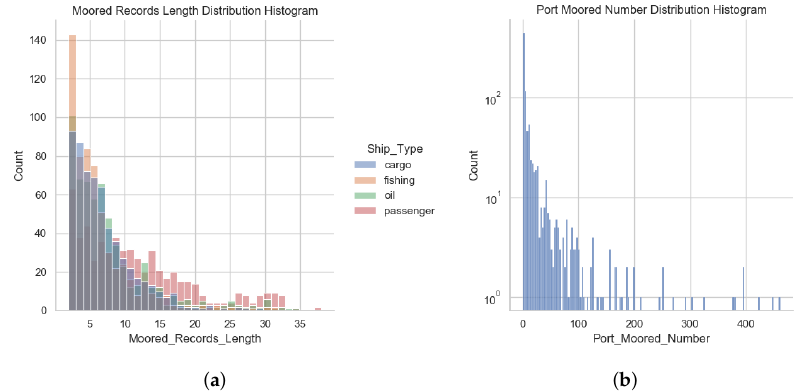
Figure 4. Ship moored records distribution histogram. From the perspective of ships and ports, we calculate the distribution of moored records, and counted ship moored record distribution according to ship types. ( a ) Moored Records Length Distribution Histogram; ( b ) Port Moored Number Distribution